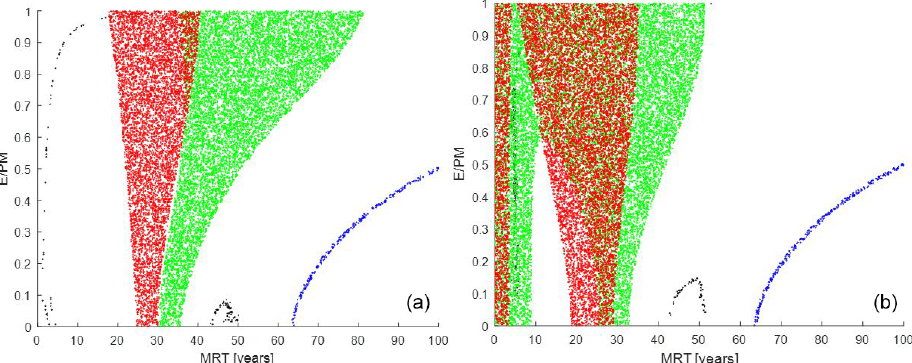
Figure 6. Typical EPM parameter could be inferred with tritium (black), CFC-11 (green), CFC-12 (red) and CFC-113 (blue). In both figures tritium, CFC-11 and CFC-12 inferred LPM parameter clouds overlap, i.e. age interpretations agree; in both figures, tritium gives ambiguous age estimates, and in the right panel CFC-11 and CFC-12 also give ambiguous age estimates due to recently falling atmospheric